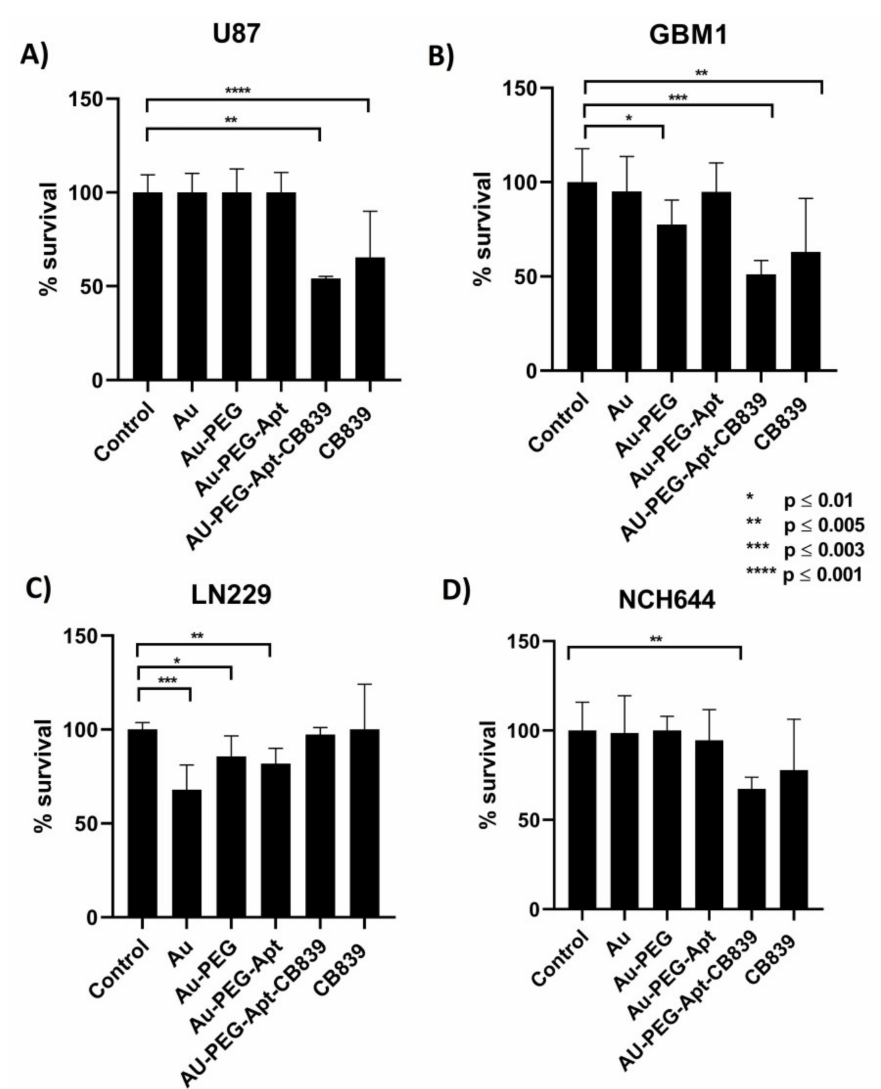
Figure 8. MTT assay in GSCs and GBM cells; ( A ) U87, ( B ) GBM1, ( C ) LN229, and ( D ) NCH644. The majority of groups have been affected considerably by Au-PEG-CD133 and